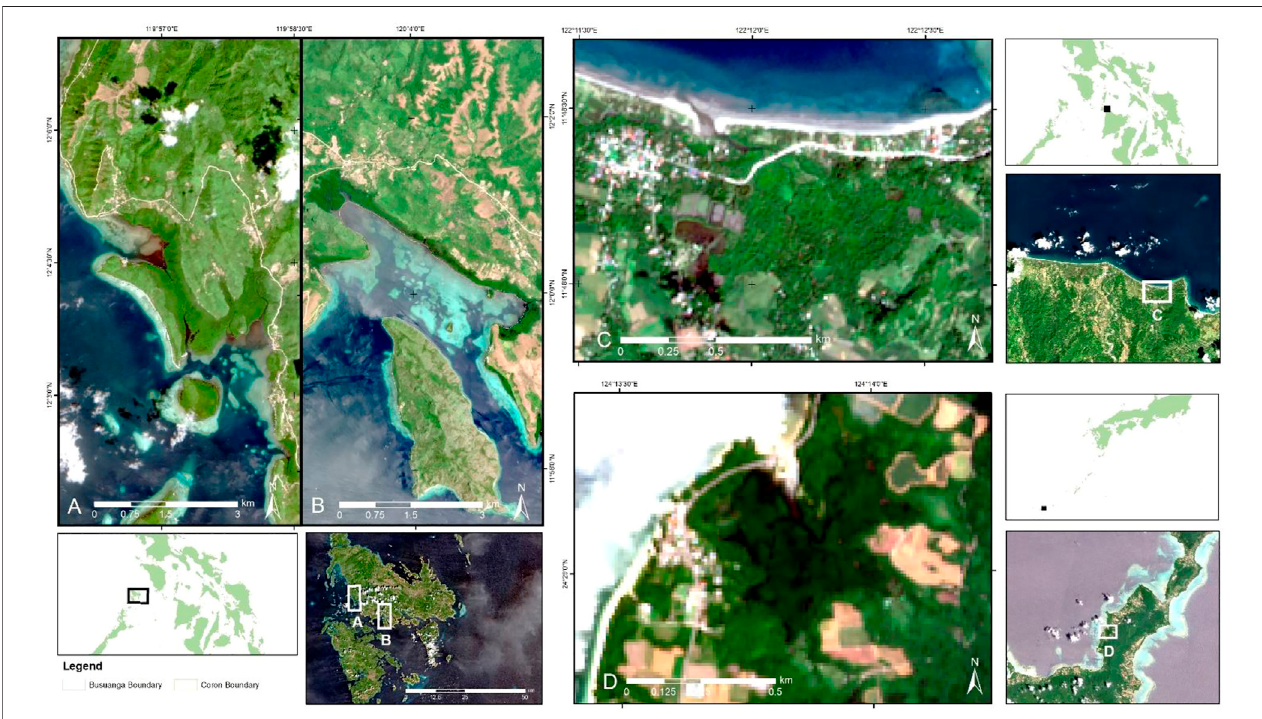
FIGURE 1 | Location of the study sites used in testing the work fl ow for mapping mangrove zonation: (A) Busuanga, (B) Coron and (C) Katunggan-It Ibajay Ecopark, Aklan in the Philippines and (D) Fukido Mangrove Park in Ishigaki, Japan. Sentinel-2 RGB image per site is shown in the map.